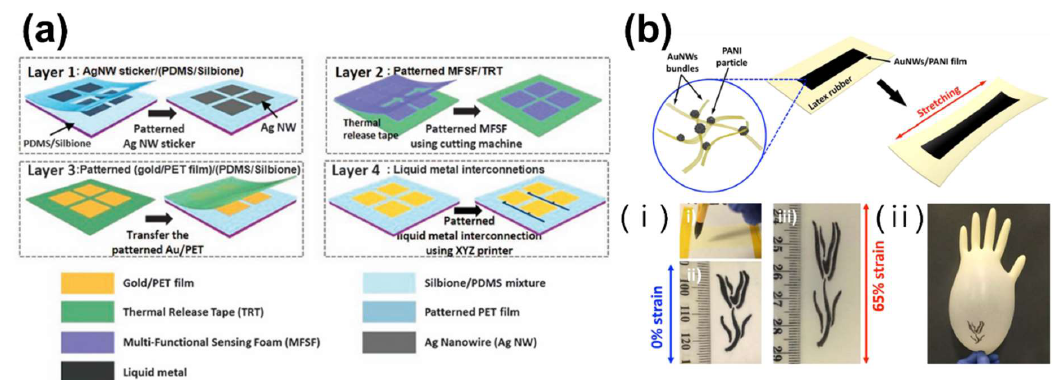
Figure 8. Schematic illustrations. ( a ) Fabrication of a sensor array using PU foam coated with MWCNT/PANI composite [168]. Copyright © 2021, the author(s). ( b ) AuNW/PANI strain sensors. (i) Writing AuNW/PANI film using a paint brush. (ii) Photograph of a rose-patterned glove after being inflated with air [174]. Copyright © 2021, American Chemical Society.